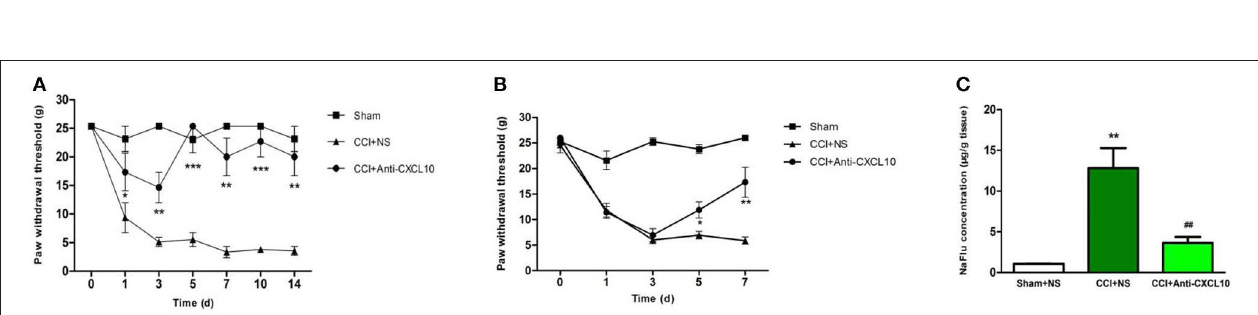
FIGURE 4 | Neutralizing CXCL10 alleviated hyperalgesia and reduced CCI-induced BSCB disruption. (A,B) Hindpaw PWTs in CCI + anti-CXCL10 antibodies group and CCI + saline group rats on various experimental days (* p < 0.05, ** p < 0.01, *** p < 0.001; ANOVA, n = 5–6). (C) Lumbar spinal cord NaFlu concentrations in the CCI + anti-CXCL10 antibodies group, CCI + saline group, and sham surgery group rats on experimental day 3 (* p < 0.01, CCI + NS group vs. sham surgery group; Mann–Whitney U- test, n = 4–6; ## p < 0.01, CCI + anti-CXCL10 antibodies group vs. CCI + NS group; independent t- test, n = 6). The data are shown as means ± standard errors. ANOVA, analysis of variance; BSCB, blood-spinal cord barrier; CCI, chronic constriction injury; CXCL10, C-X-C motif chemokine 10; NaFlu, sodium fluorescein; PWT, paw withdrawal threshold; NS, normal saline.